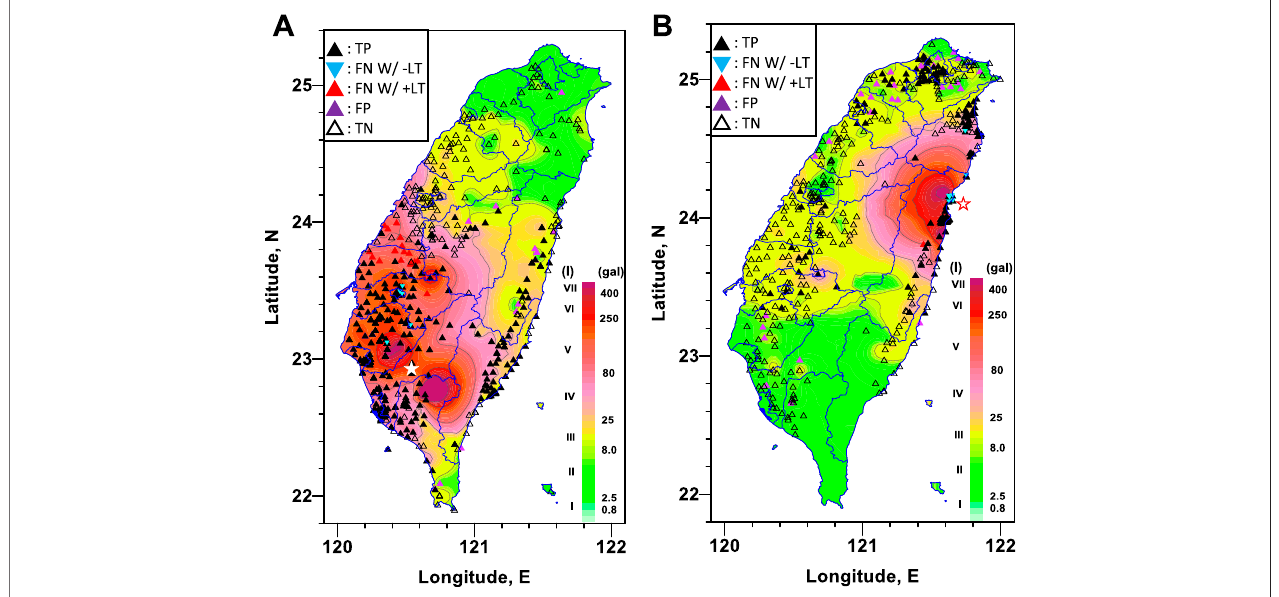
FIGURE 14 | The locations of the stations of different classi fi cation conditions of the (A) Meinong data set, and (B) Hualien data set. The background indicates the distribution of observed PGA. LT is lead time, and the star marker is the epicenter.